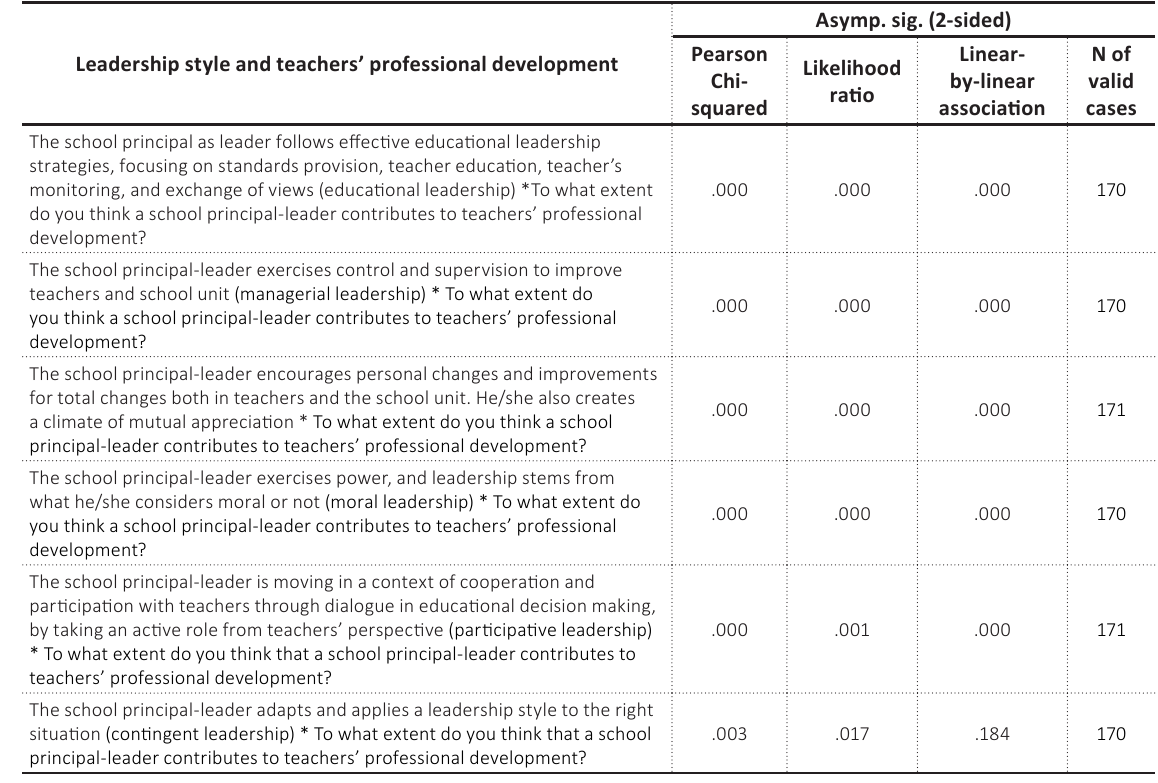
Table 10. Chi-squared analysis for hypothesis H